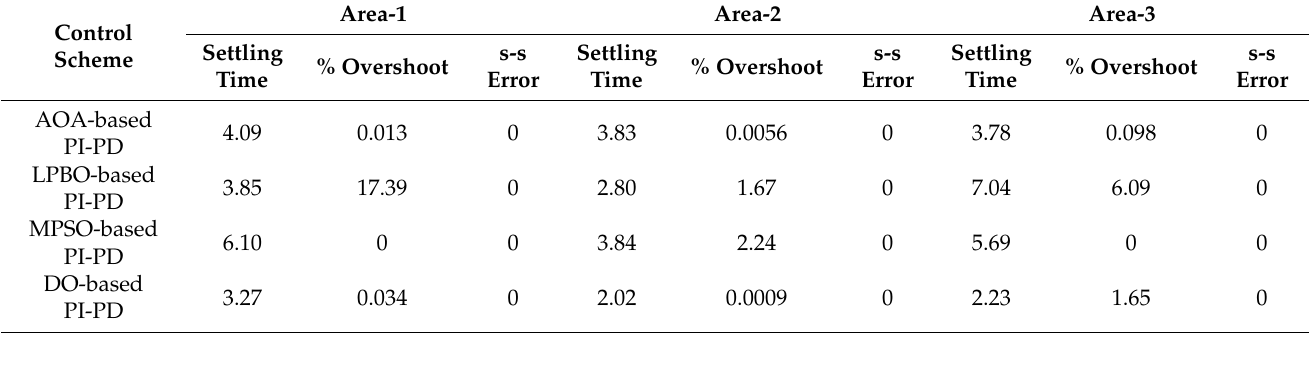
Table 14. Numerical results of AVR in a three-area multi-source IPS with nonlinearities.